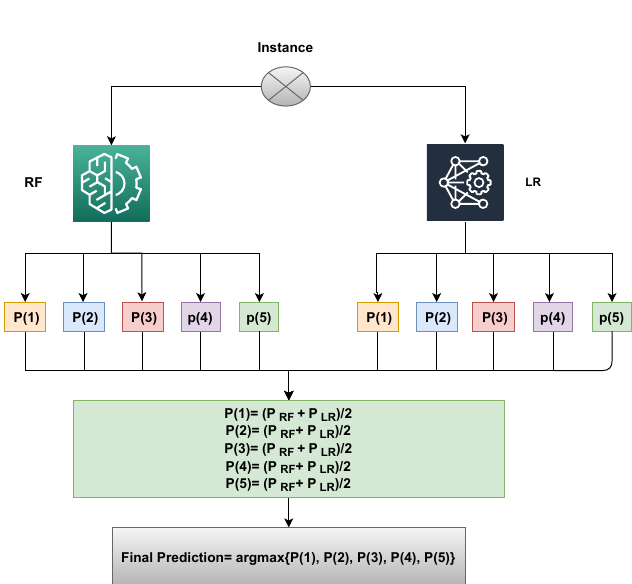
Figure 12. Proposed voting classifier architecture